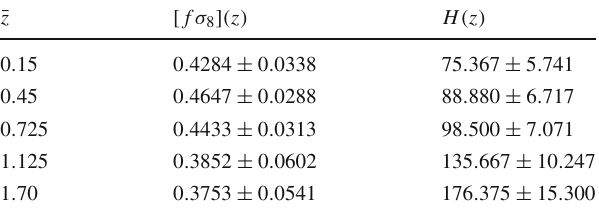
Table 3 Binned data of [ f σ 8 ] ( z ) and H ( z ) obtained by calculating the variance weighted mean in each redshift bin (see the text for